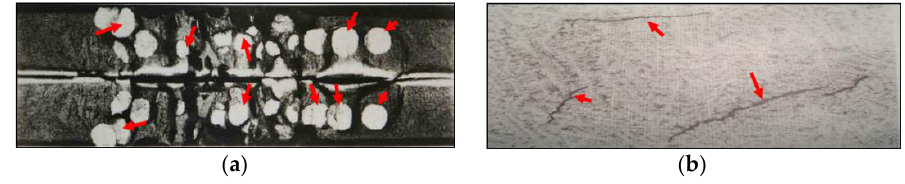
Figure 1. Flake shape in heavy forging: ( a ) flakes on a longitudinal section; ( b ) flakes on a cross section.